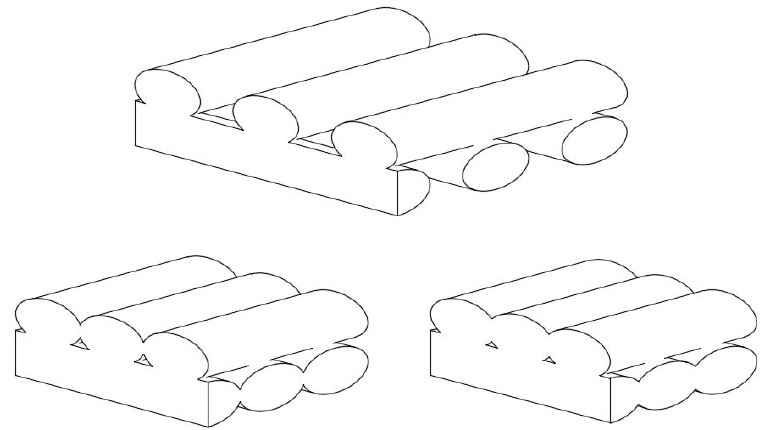
Figure 8. Tracks interaction of different theoretical volume fractions of the infill structure: 40% ( top ), 80% ( left ), 100% ( right ).